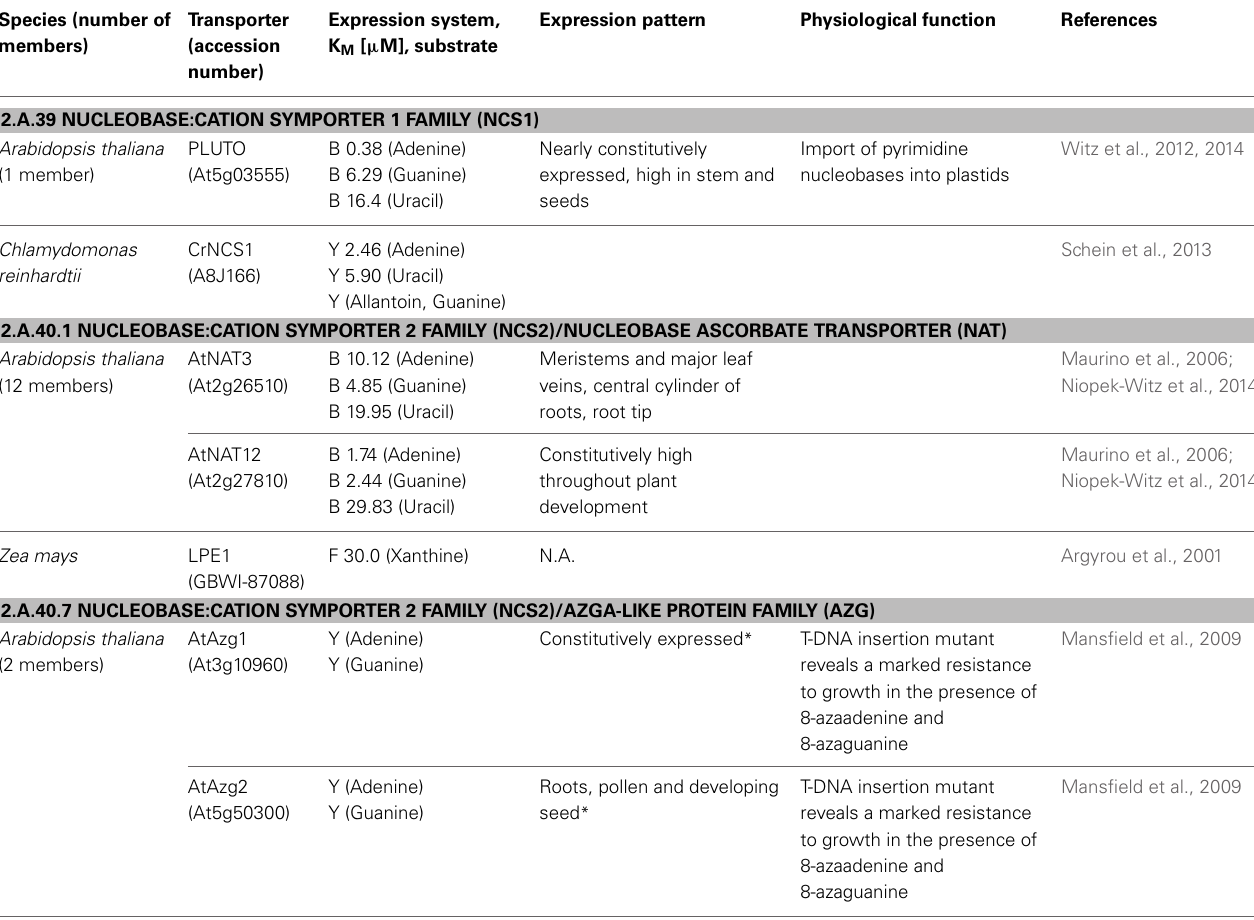
Table 3 | Nucleobase transporters of the NCS1 and NCS2 families. Species (number